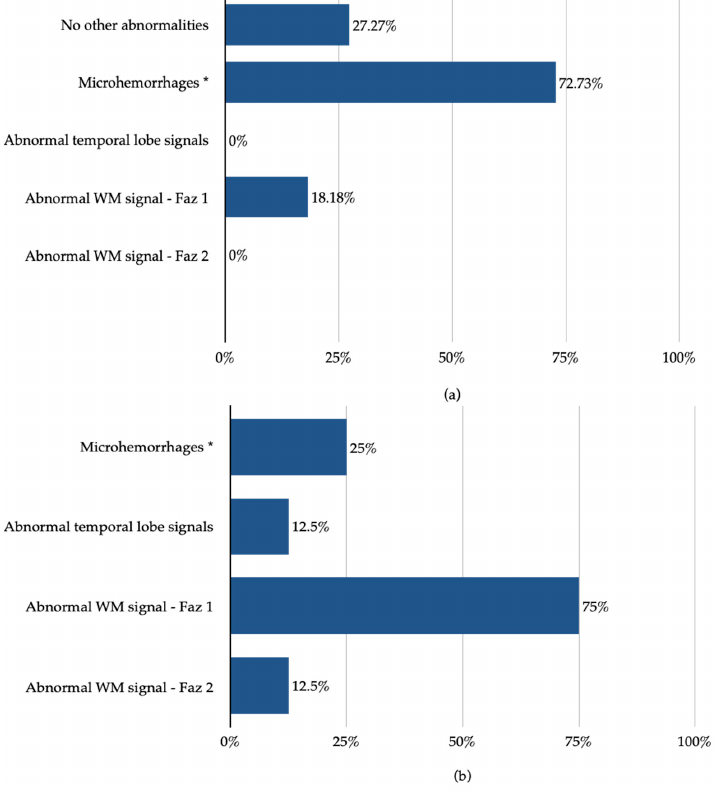
Figure 3. MRI findings in the study population: ( a ) MRI study in patients with acute cerebral stroke, ( b ) MRI study in patients without acute cerebral stroke. Legend: Faz 1—hyperintense white matter foci on T2/FLAIR images meeting the Fazekas scale 1 criteria, Faz 2—hyperintense white matter foci on T2/FLAIR images meeting the Fazekas scale 2 criteria, WM—white matter. *—the incidence of